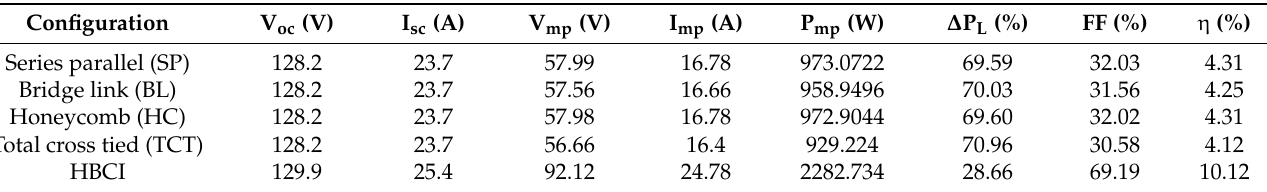
Figure 11. Case 3: long and wide shading: ( a ) the SP array configuration; ( b ) after reconfiguration with HBCI; ( c ) reconfigu- ration with HBCI; ( d ) PV characteristics. Table 4. Case 3: long and wide